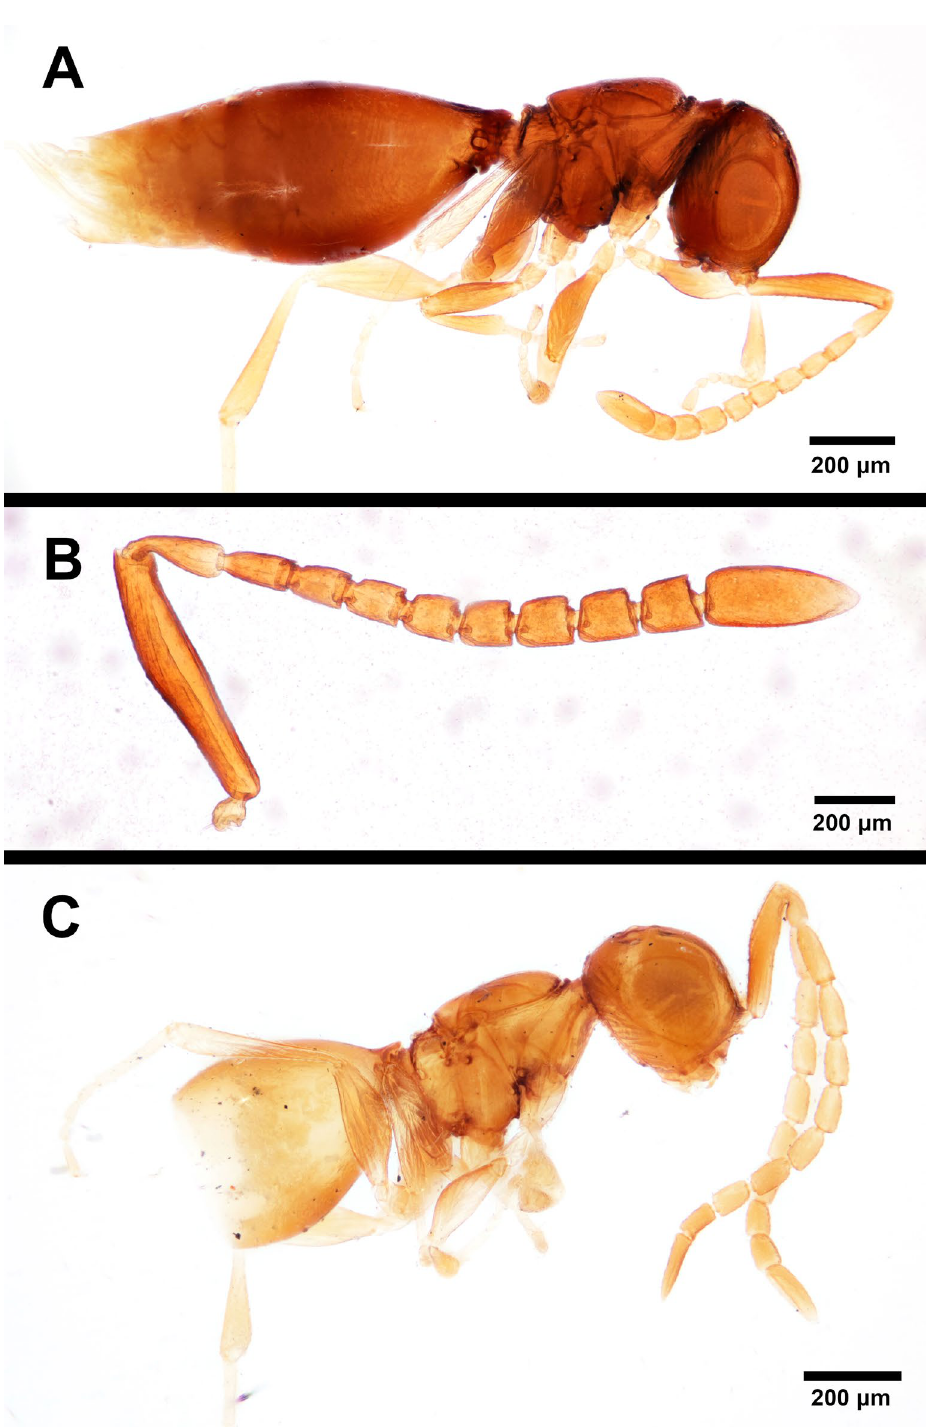
Fig. 21. Conostigmus pedester kieffer, 1913. A–B . Lectotype, ♀. A . Specimen in ethanol, lateral view (MNhN EY25354). B . Left antenna (MNhN EY22452). C . Paralectotype, ♂, in ethanol, lateral view (MNhN